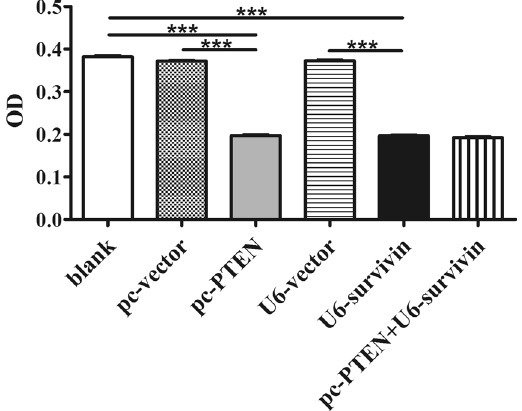
Figure 4. CCK-8 test for cell proliferation. The proliferation rate was significantly reduced in PTEN over- expression and survivin down-regulated RA-FLS. But no more reduction was found in co-transfection RA-FLS. “ *** ” stands for P <